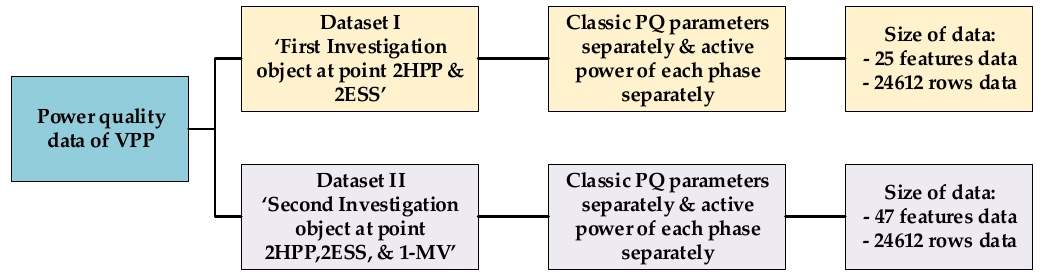
Figure 2. Proposed dataset schema: description of dataset separation, parameters, and size of data.